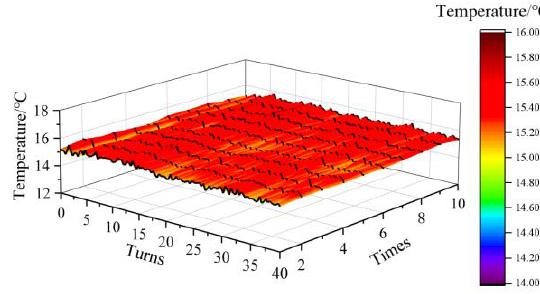
Figure 10. Winding original Figure 10 . Winding original temperature.